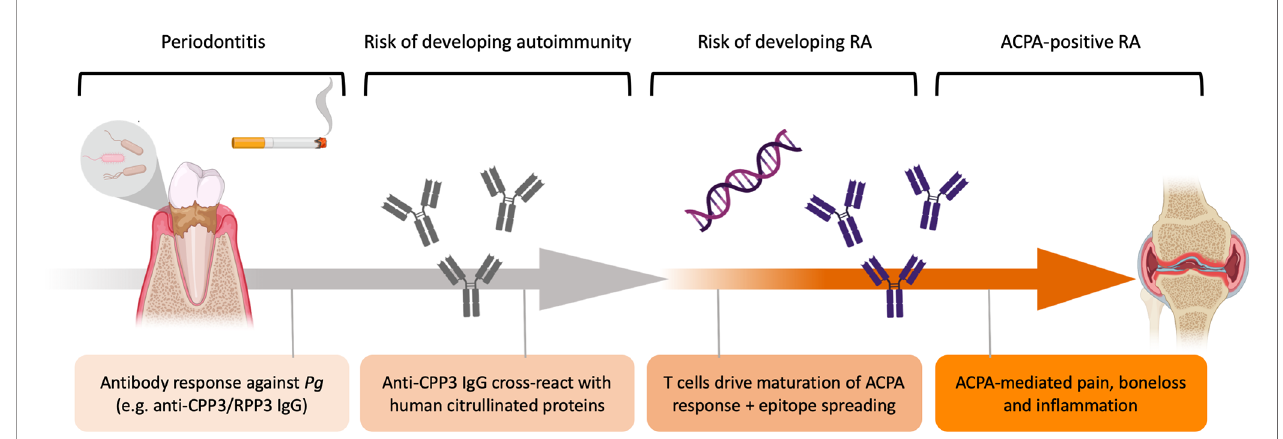
FIGURE 5 | Schematic illustration of the etiological hypothesis linking Pg to ACPA+ RA. P. gingivalis drives gingival in fl ammation with increased protein citrullination, in the context of cigarette smoking. Immune responses against Pg includes anti- P. PAD antibody responses, such as anti-CPP3/RPP3 IgG, which could cross-react with human citrullinated proteins exposed in the in fl amed periodontium by mechanisms of molecular mimicry. In genetically susceptible individuals (e.g. HLA-DRB1 SE), autoreactive T cells drive af fi nity maturation of the ACPA response targeting self-proteins. High-af fi nity autoreactive ACPA subsequently bind proteins expressed in the joints and trigger pain, bone loss and synovial in fl